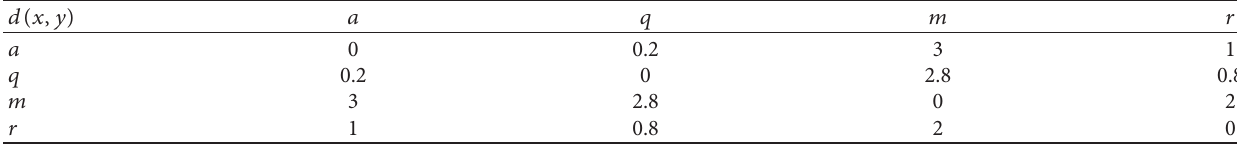
Table 1: Table of metric d for Example 2.